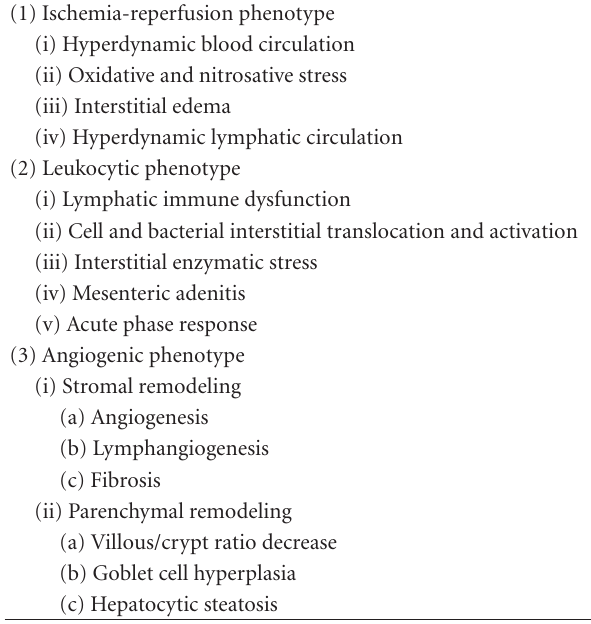
Table 1: Splanchnic inflammatory phenotypes in the portal hyper- tensive